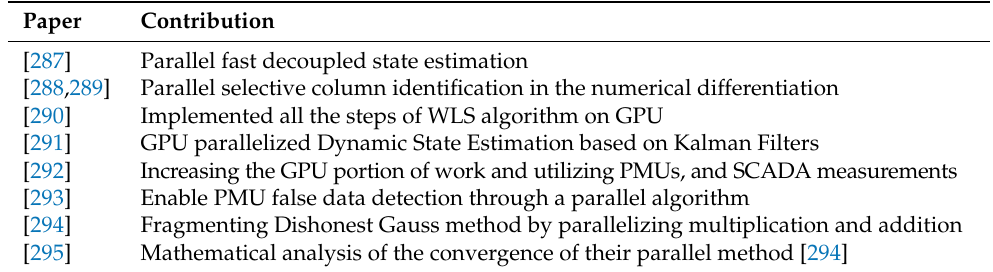
Table 8. State Estimation SIMD-based state-of-the-art studies.